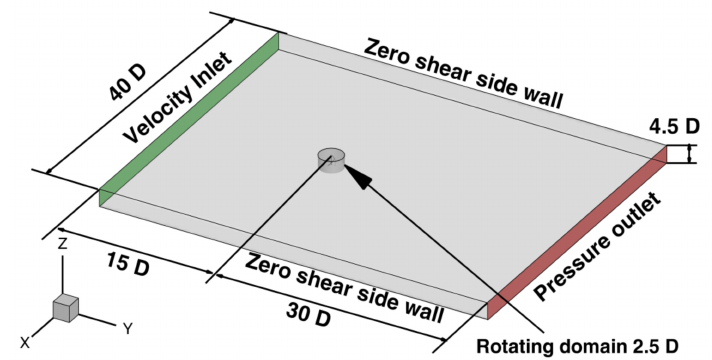
Figure 2. Domain consisting of the stationary cuboidal domain and rotating cylindrical domain.